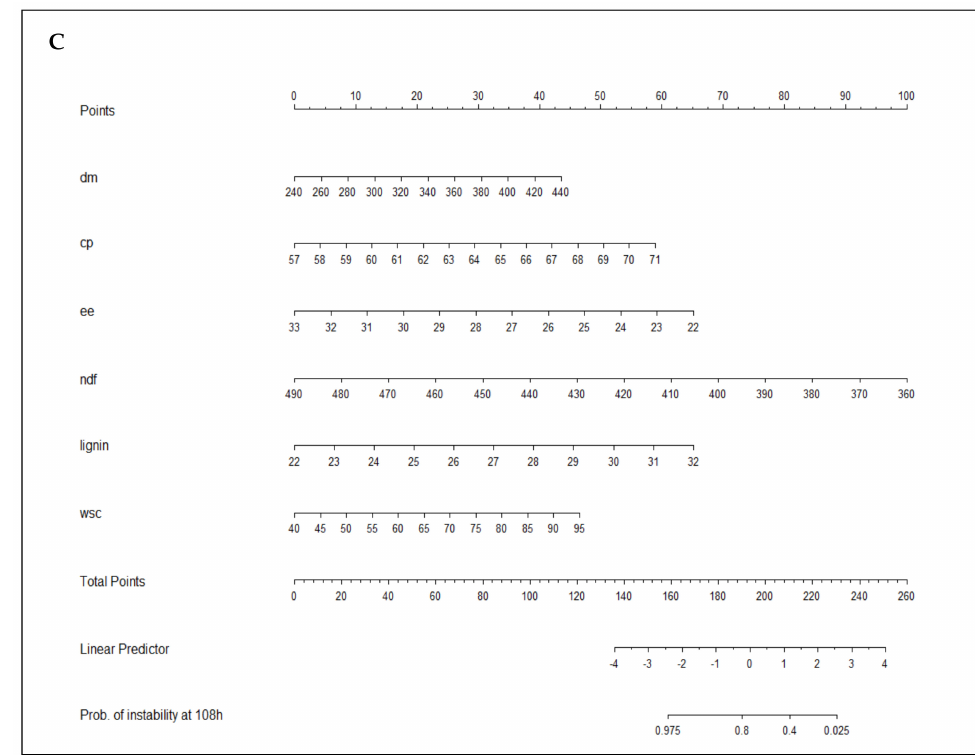
Figure 4. Nomogram from fitted cox proportional hazard regression model relating the predictor variables, such as dry matter (DM), crude protein (CP), fat (EE), aNDF, lignin (sa), and water-soluble carbohydrates (WSC), to the event. The risk of aerobic stability failing in each sample was calculated as follows: partial risk scores, given by the predictor variables, read on the upper scale; sum reported on total score scale allows estimation of the corresponding risk using linear predictor, as well as 48 ( A ), 96 ( B ), and 108 h ( C ) aerobic stability success rate